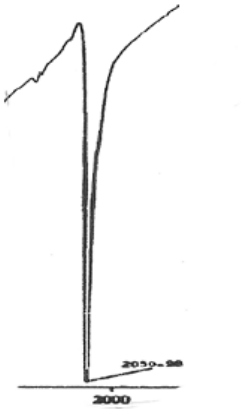
Figure 1. IR spectrum of Ni(II) thiocynato